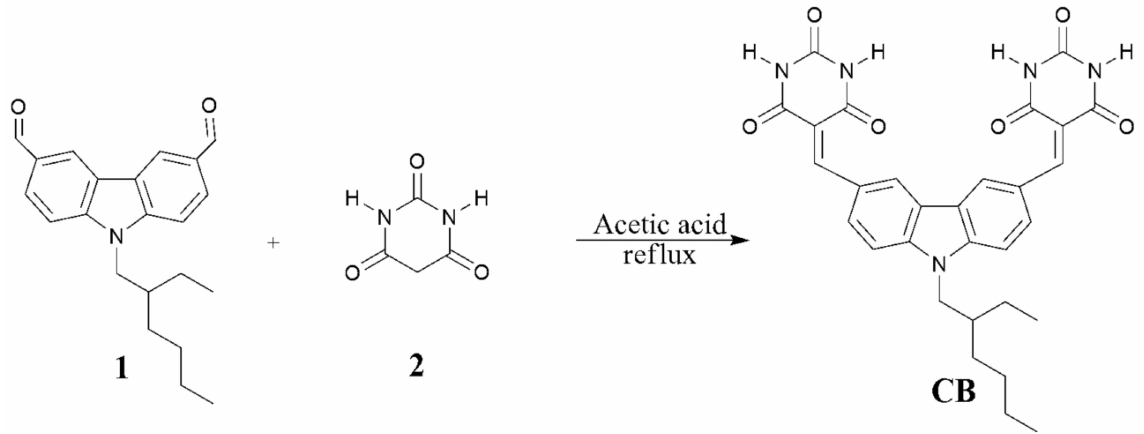
The absorption and emission spectra of CB showed the characteristic peaks of car- bazole fluorophore at 284, 327, 386, and 453 nm in the UV spectrum and an emission peak at 520 nm upon excitation at 465 nm. The absorption peak at 450 nm indicates the presence of the extended conjugation of the fluorophore with the two barbiturate groups, which leads to absorption at a higher wavelength [19]. The emission peak was also shifted to a higher wavelength compared to that of the starting material (1) (Figure 1), but at a much lower intensity; these observations were most likely due to the extended conjugation.